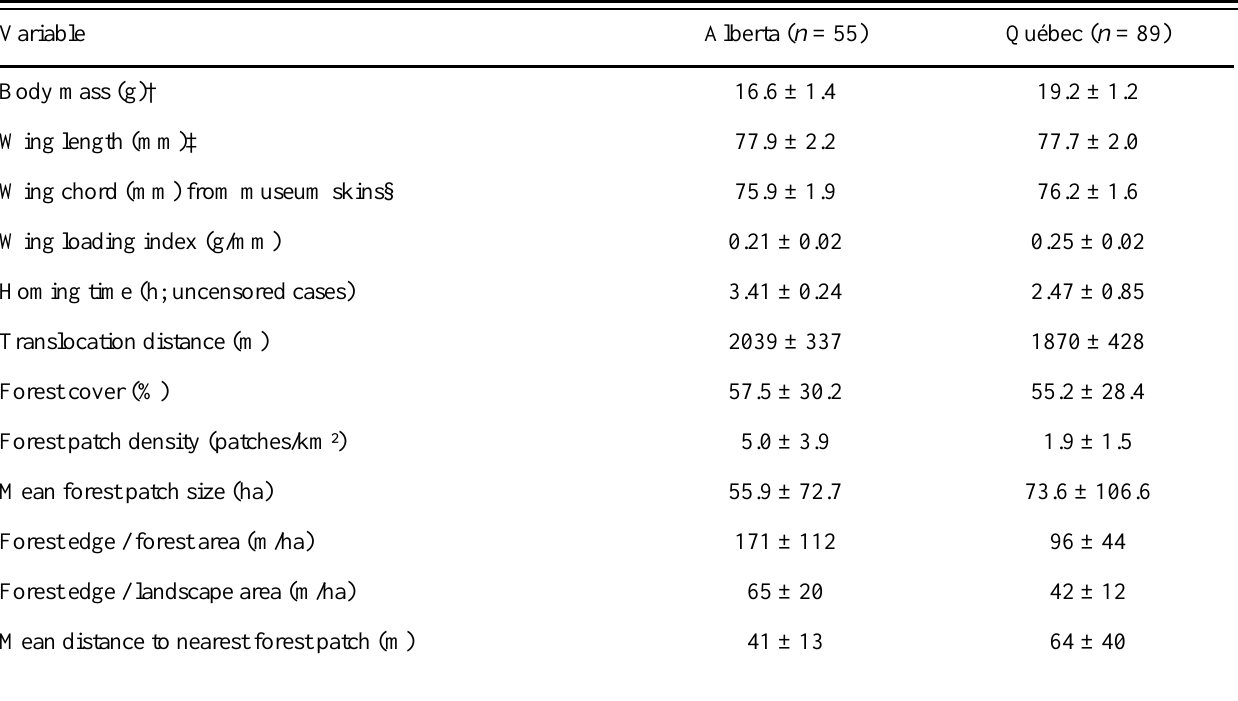
Table 1. Regional comparison of Ovenbird body measurements and landscape structure. Means and standard deviations are